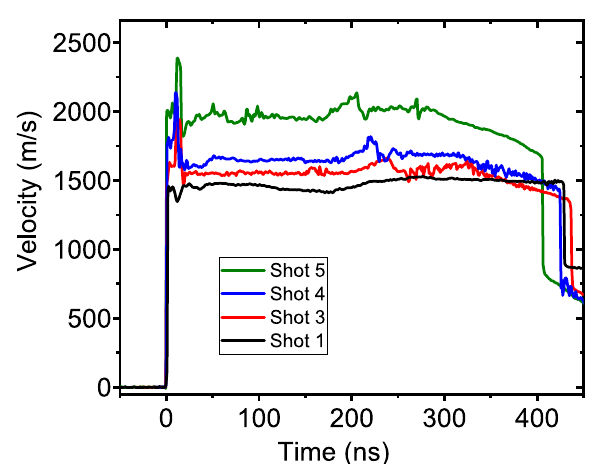
Figure 6. Measured Sm-LiF interface velocities in plate impact experiments. Time zero corresponds to shock breakout